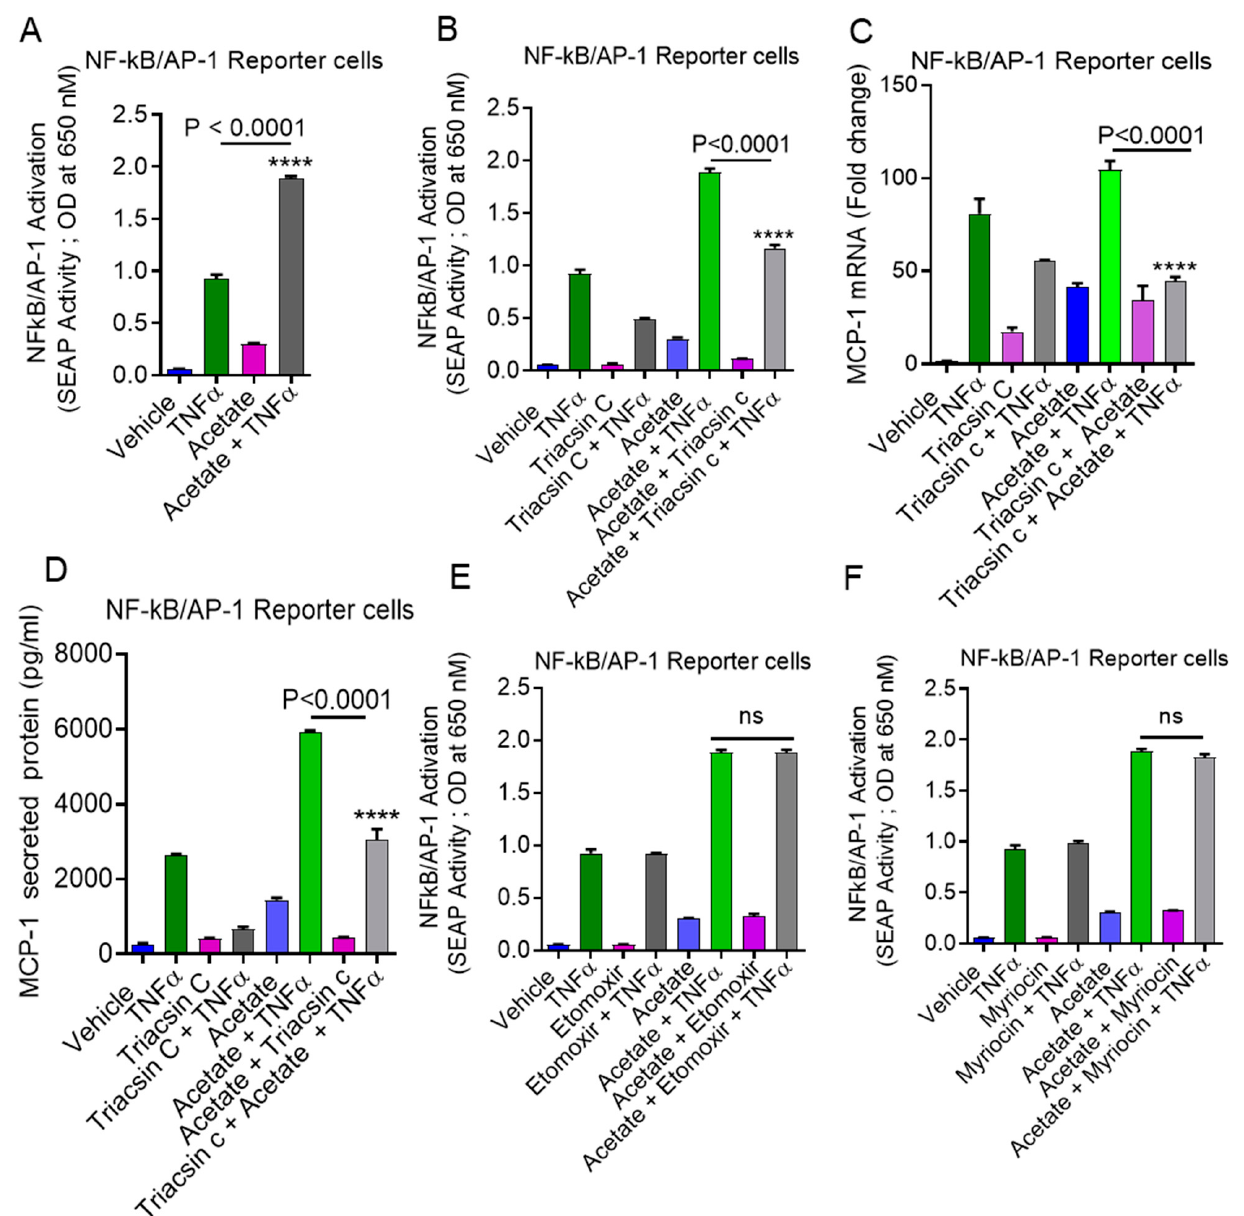
Figure 8. TNF α together with acetate increases NF- κ B/AP-1 activity. ( A ) THP1-XBlue cells (monocytic cells stably expressing a SEAP reporter inducible by NF- κ B and AP-1) were treated with vehicle or TNF α and acetate alone or in combination, for 24 h. Culture media were collected. Cell culture media were assayed for SEAP reporter activity (the degree of NF- κ B/AP-1 activation). ( B ) Cells were pretreated with triacsin c and then exposed to acetate/TNF α . Degree of NF- κ B/AP-1 activation was measured. ( C ) Total RNA was isolated from reporter cells to assess the MCP-1 gene expression using real-time RT-PCR. ( D ) MCP-1 protein was determined in the supernatant. ( E , F ) Reporter cells were treated with etomoxir or myriocin before being treatedwith acetate/TNF α . Degree of NF- κ B/AP-1 activation measured. The results obtained from three independent experiments are shown. All data are expressed as mean ± SEM (n = 3). **** p < 0.0001 versus TNF α alone. ns indicates non-significant.